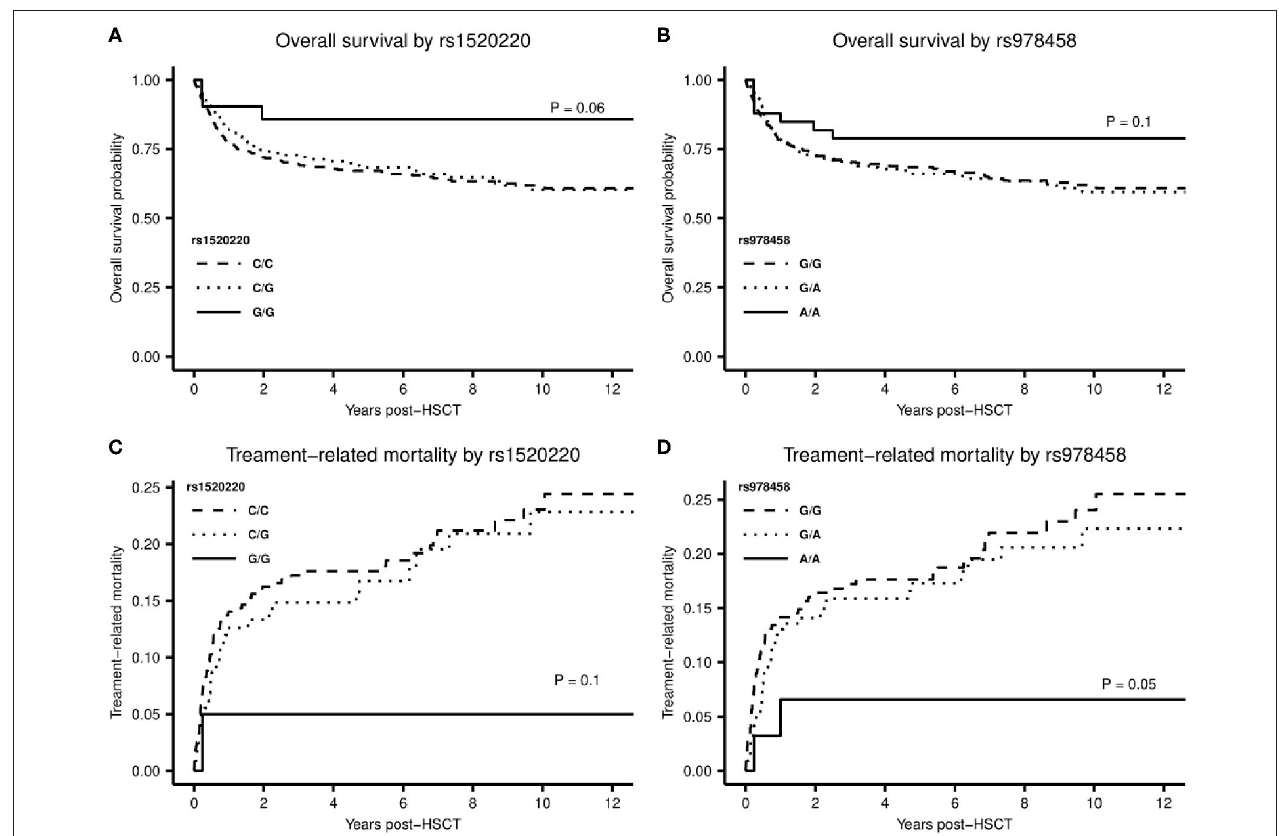
FIGURE 4 | (A,B) Kaplan-Meier plot with log-rank test for difference in overall survival between the homozygote minor allele genotype and the other genotypes of rs1520220 (A) , P = 0.06 and rs978458 (B) , P = 0.1. (C,D) Cumulative incidence plot for treatment-related mortality stratified by genotypes of rs1520220 (C) and rs978458 (D) . (C) difference between the G/G genotype and the other genotypes (genotype distribution: C/C: n = 361, C/G: n = 160, G/G: n = 21), P = 0.1. (D) difference between the A/A genotype and the other genotypes (genotype distribution: G/G: n = 297, G/A: n = 213, A/A: n = 33), P =